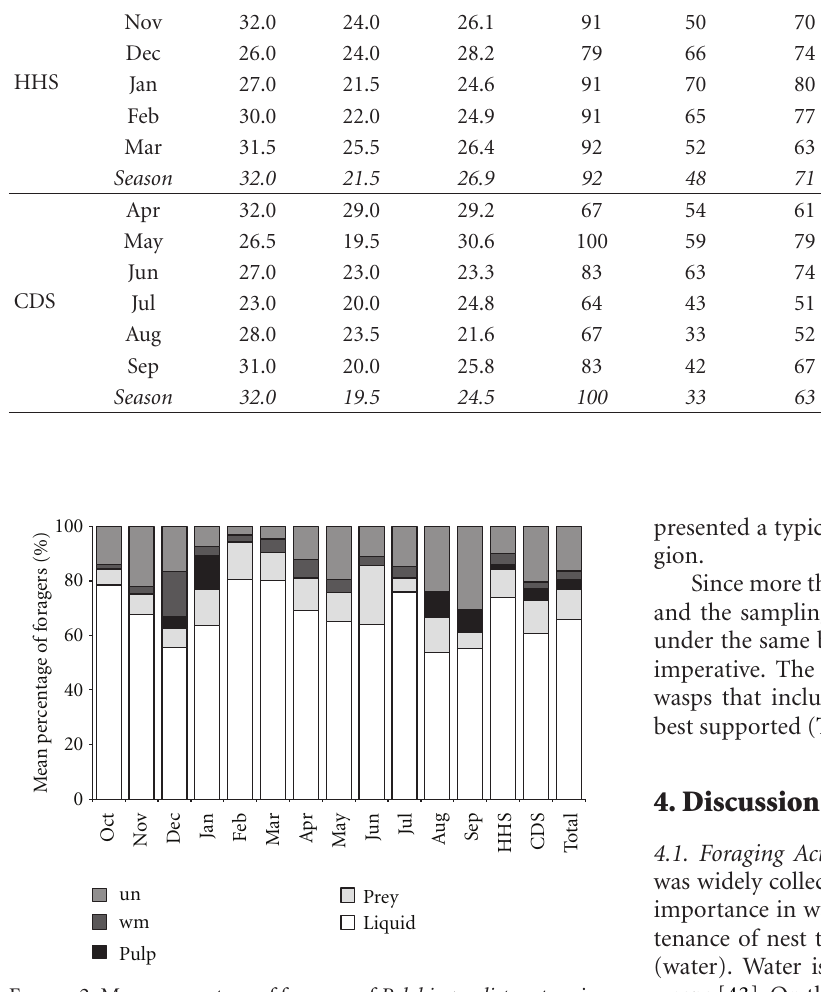
Figure 2: Mean percentage of foragers of Polybia paulista returning to the nest for each day of observation bringing liquid, prey, pulp, nothing (wm), and unidentified material (un) for each month, season, and the entire year. HHS: hot and humid season. CDS: cold and dry